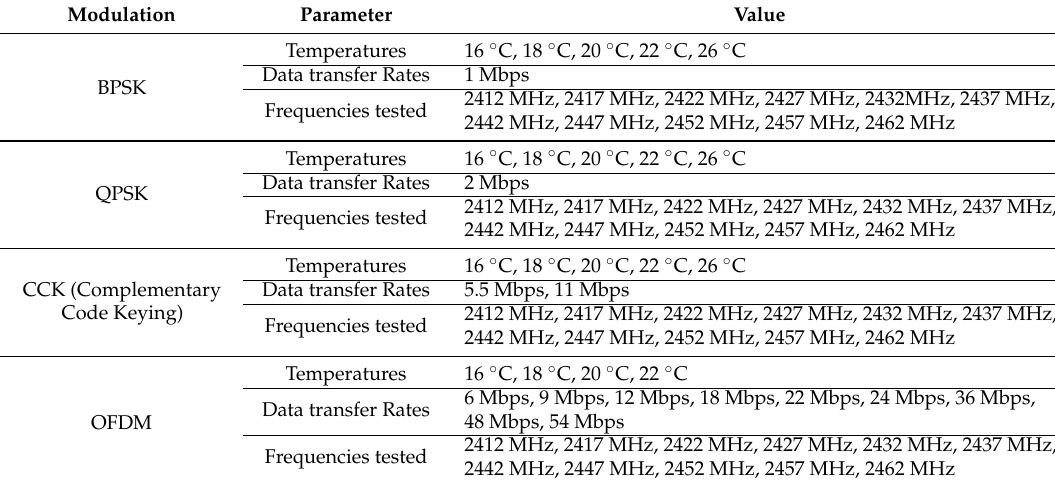
Table 2. Parameters analyzed in the tests